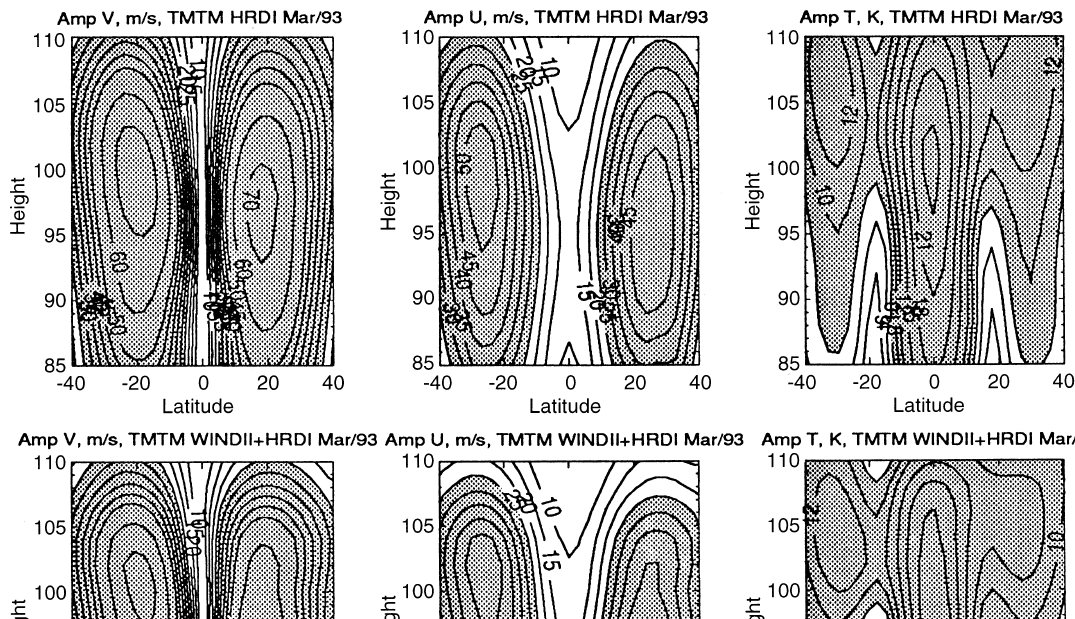
Fig. 5. The diurnal amplitude structures of zonal and meridional winds and temperatures for March 1993. First two rows are predictions generated by TMTM using di(cid:128)erent initial guesses for the iterative procedure. First two plots in the bottom row are the